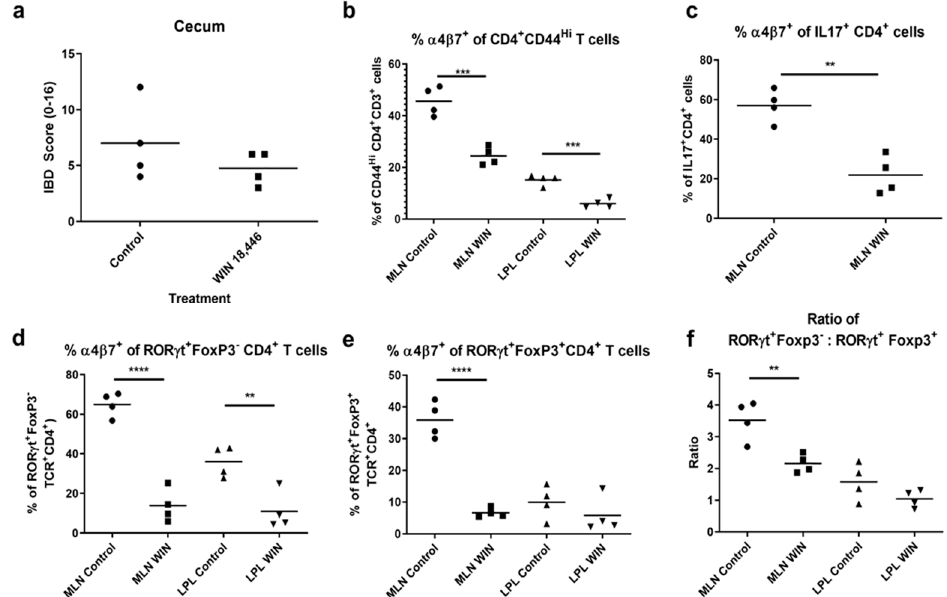
Figure 3. WIN 18,446 treatment results in decreased α 4 β 7 integrin expression in activated (CD44 Hi ) CD4 + T cells, IL ‐ 17 + T cells and ROR γ t + CD4 + T cells and reduced Th17: induced Treg ratios in MLN and/or LPL during early inflammation. Mice were fed WIN 18,446 (WIN) ‐ containing or control diets (N = 4 mice per group) for 3 weeks and then infected with H. bilis . Cell suspensions generated from MLN and LPL were stained with combinations of anti ‐ CD3 or TCR β , CD4, CD8, CD44, IL ‐ 17F, Foxp3,